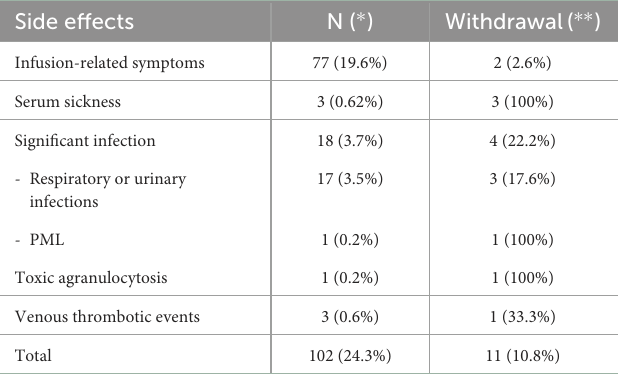
TABLE 2 Main side effects and withdrawals for this